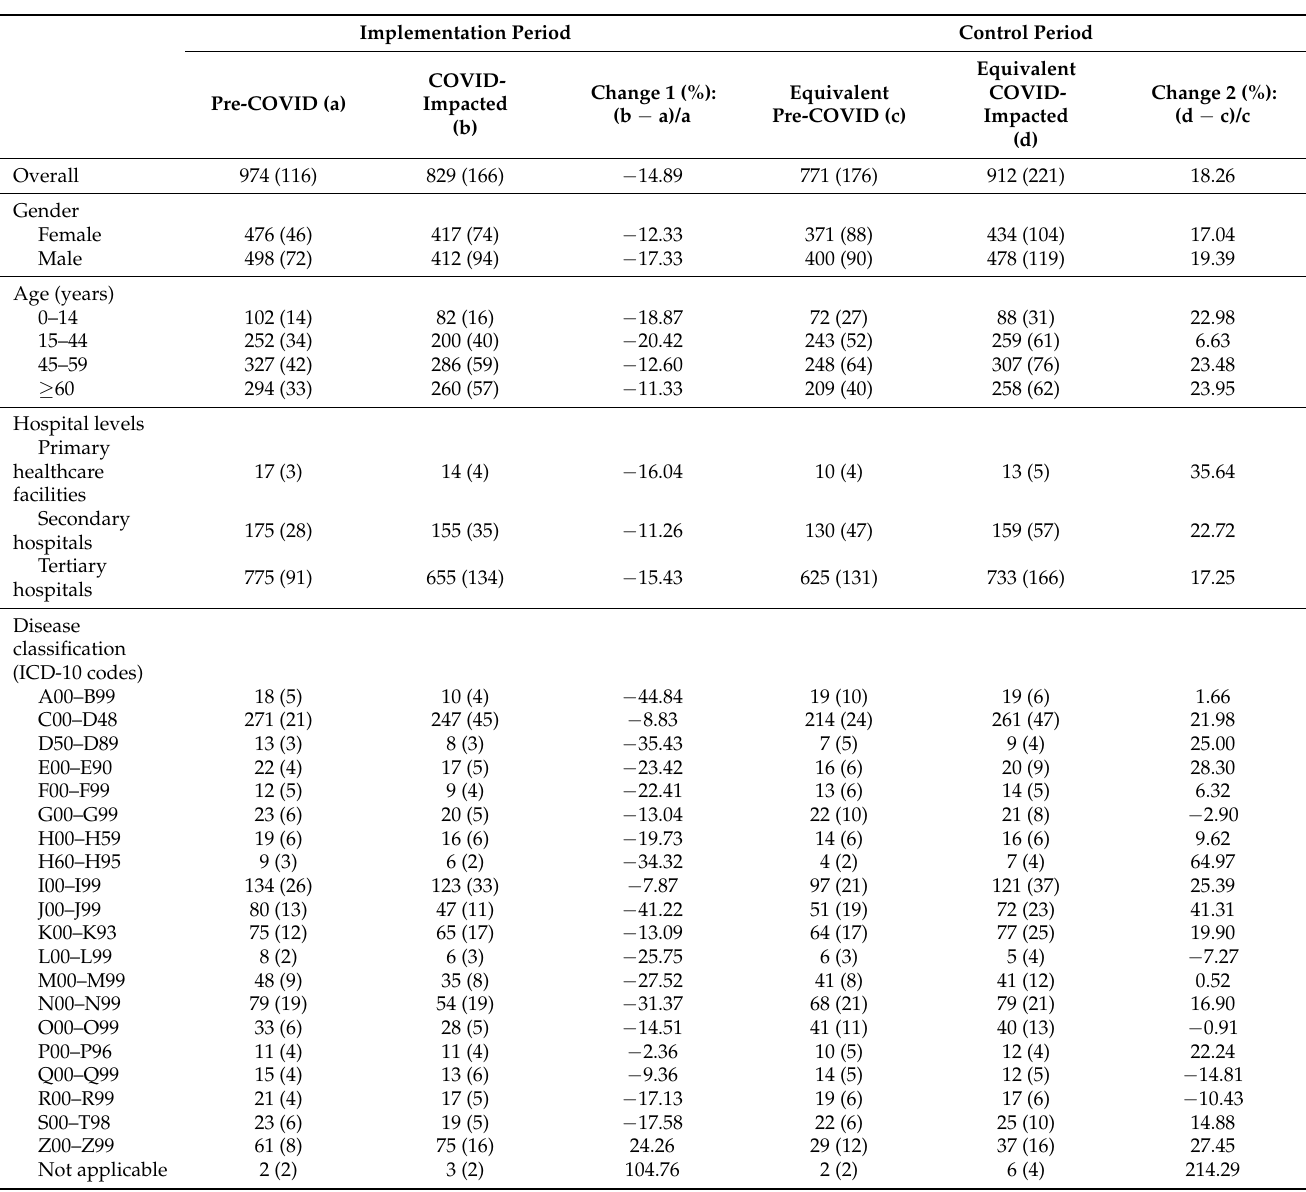
Table 3. Average monthly hospital visits in the out-of-city area for rural residents, shown as mean